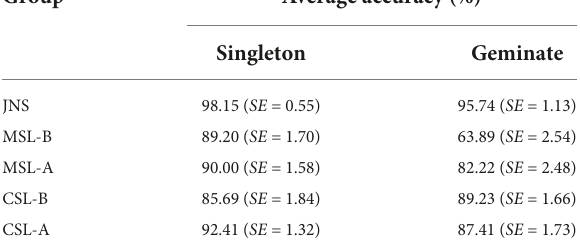
TABLE 2 Mean accuracies for words with singleton vs. geminate among the five